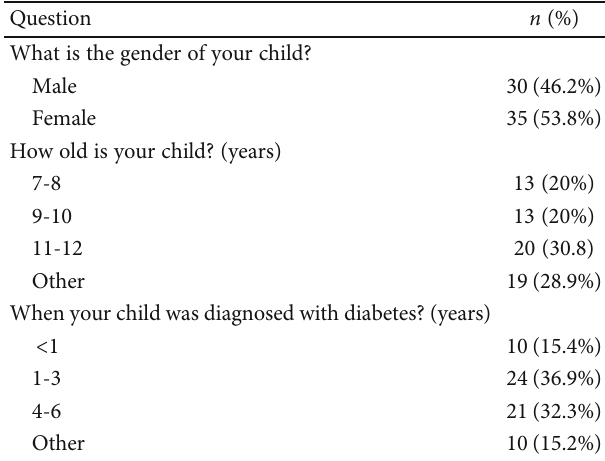
Table 2: Demographic information of children with